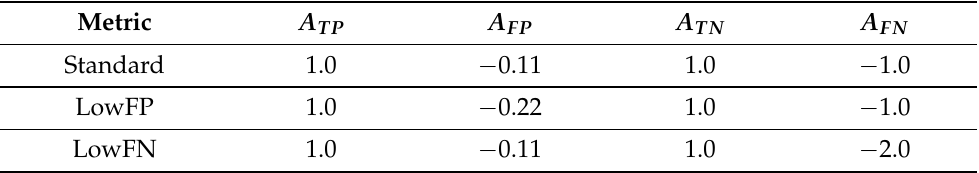
Table 1. Application profile for NAB scoring algorithm.